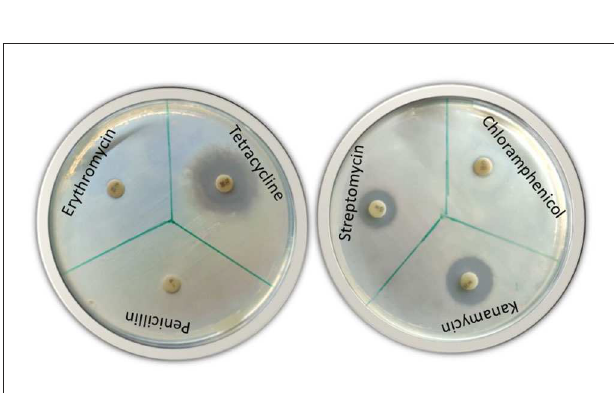
FIGURE2 Antibiotic susceptibility test of bacterial isolate BC-II-20 against six different antibiotics (streptomycin, penicillin, chloramphenicol, kanamycin, tetracycline, and